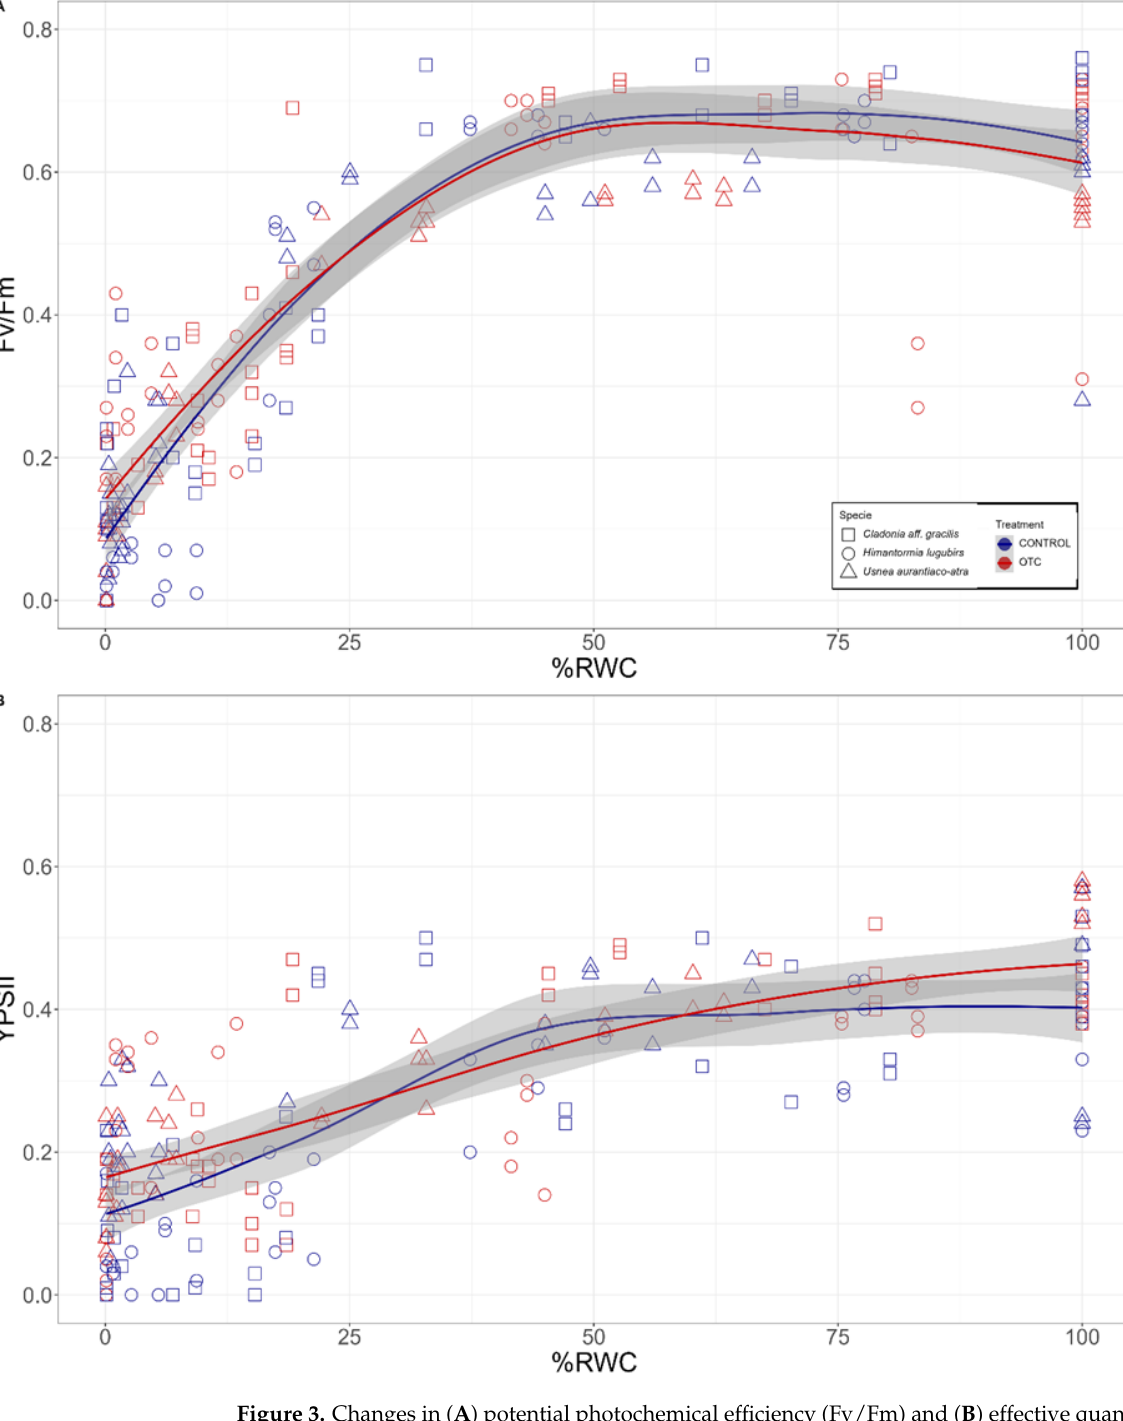
Figure 3. Changes in ( A ) potential photochemical efficiency (Fv/Fm) and ( B ) effective quantum yield (YPSII) in response to desiccation in Antarctic lichens from fully hydrated thalli (RWC = 100%) to a dry state (RWC = 0%). Tendency lines correspond to local polynomial regression fitting, and gray area indicates the standard error of the tendency lines using t-based approximation; n = 6 for each hour and species